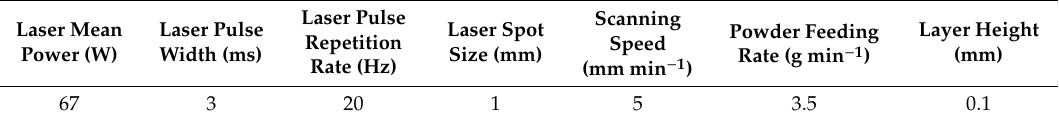
Table 2. Processing parameters of low power pulse LSF process.